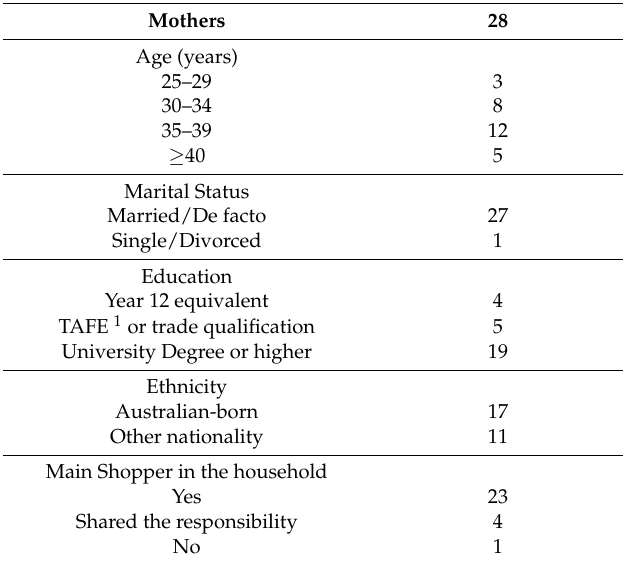
Table 1. Descriptive demographics of the sample.